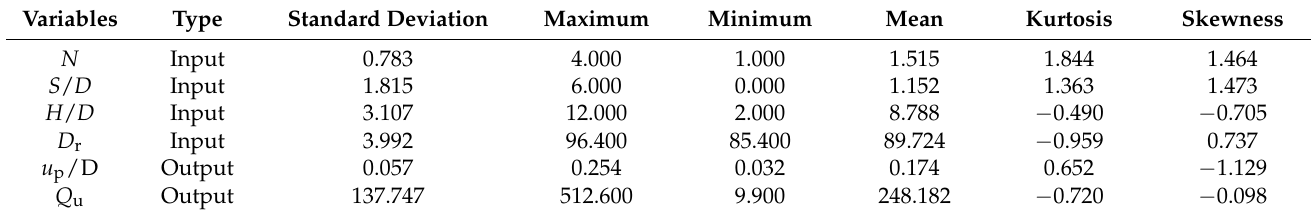
Table 3. Statistical description of inputs and outputs.